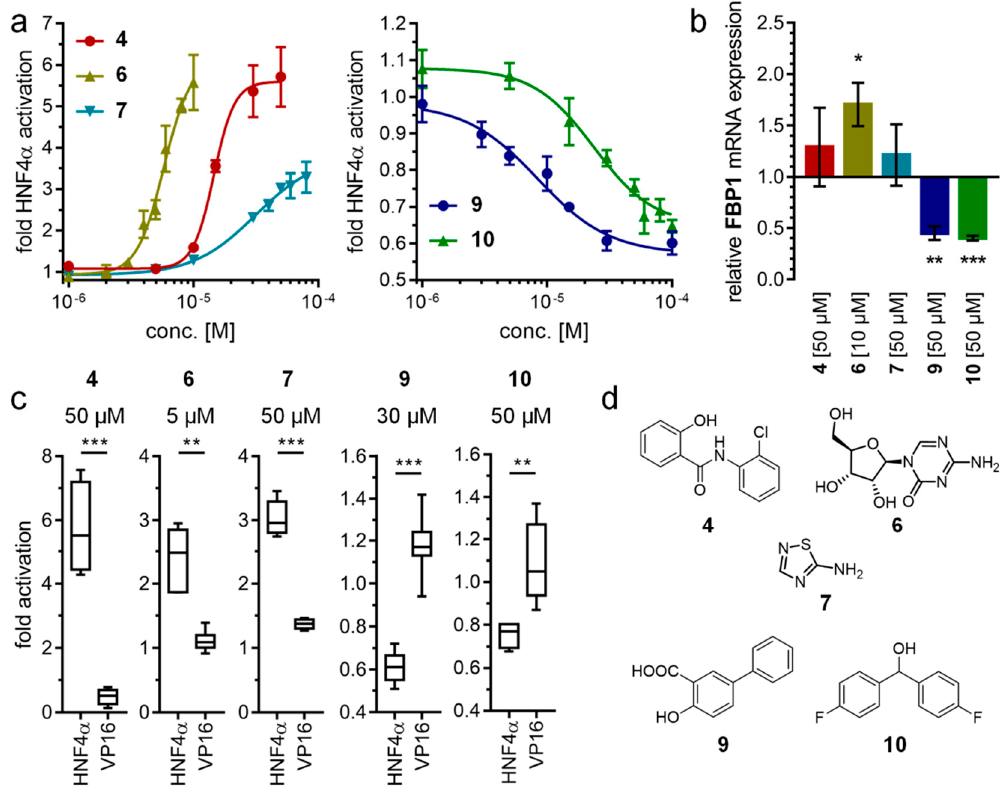
Figure 3. In vitro characterization of HNF4 α modulators 4 , 6 , 7 , 9 , and 10 . ( a ) Dose–response curves of 4 , 6 , 7 , 9 , and 10 on Gal4-HNF4 α (mean ± S.E.M.; n ≥ 4). ( b ) Effects of 4 , 6 , 7 , 9 , and 10 on mRNA expression of fructose-1,6-bisphosphatase 1 (FBP1) in human hepatocytes (HepG2). HNF4 α activators 4 , 6 , and 7 promoted FBP1 expression, while the inverse HNF4 α agonists 9 and 10 decreased FBP1 mRNA levels. Data are the mean ± S.E.M. mRNA levels determined by qRT-PCR and analyzed by the 2 - ΔΔ Ct method; n = 3. ( c ) Control experiments on Gal4-VP16 (boxplots show mean, min.-max.; n ≥ 4). ( d ) Chemical structures of 4 , 6 , 7 , 9 , and 10 . * p < 0.05, ** p < 0.01, *** p < 0.001 ( t -test). Table 3. Calculated lipophilicity and ligand e ffi ciency metrics of HNF4 α modulators. LogP and logS were retrieved from the ALOGPS 2.1 resource [20]. Ligand e ffi ciency (LE), lipophilic ligand e ffi ciency (LLE), and size-independent ligand e ffi ciency (SILE) were calculated as described in Reference [21]. ID HNF4 α Activity LogP